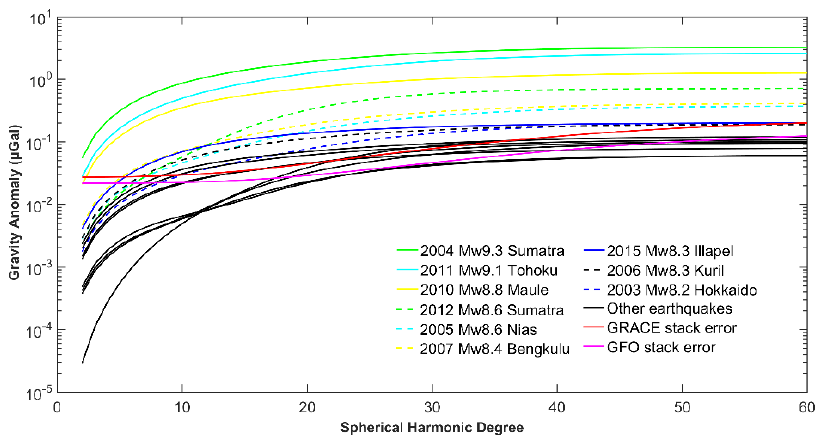
Figure 5. Cumulative degree amplitude spectra for GRACE/GFO stack errors and model-predicted coseismic gravity of earthquakes above Mw8.0 during GRACE